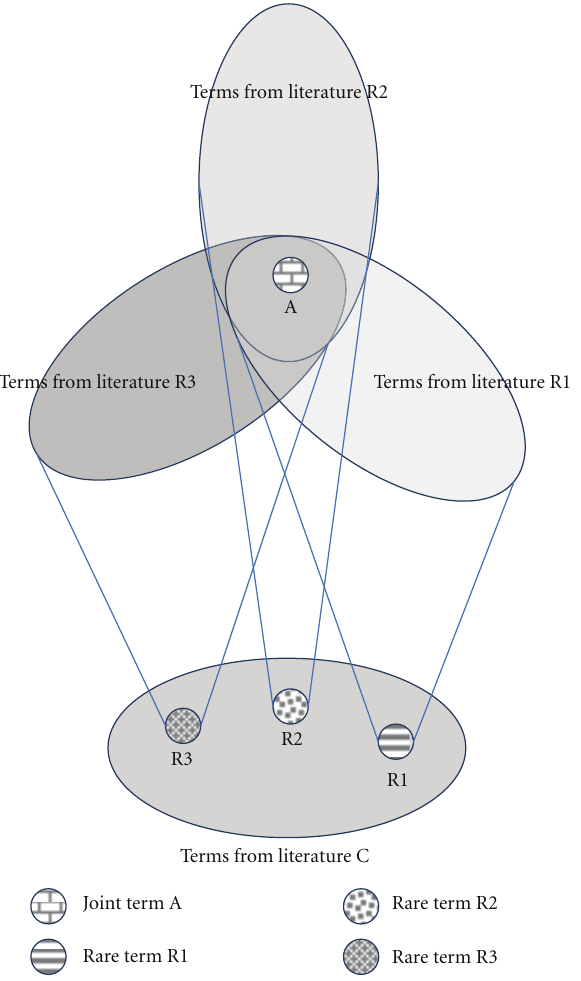
Figure 1: Principle behind RaJoLink